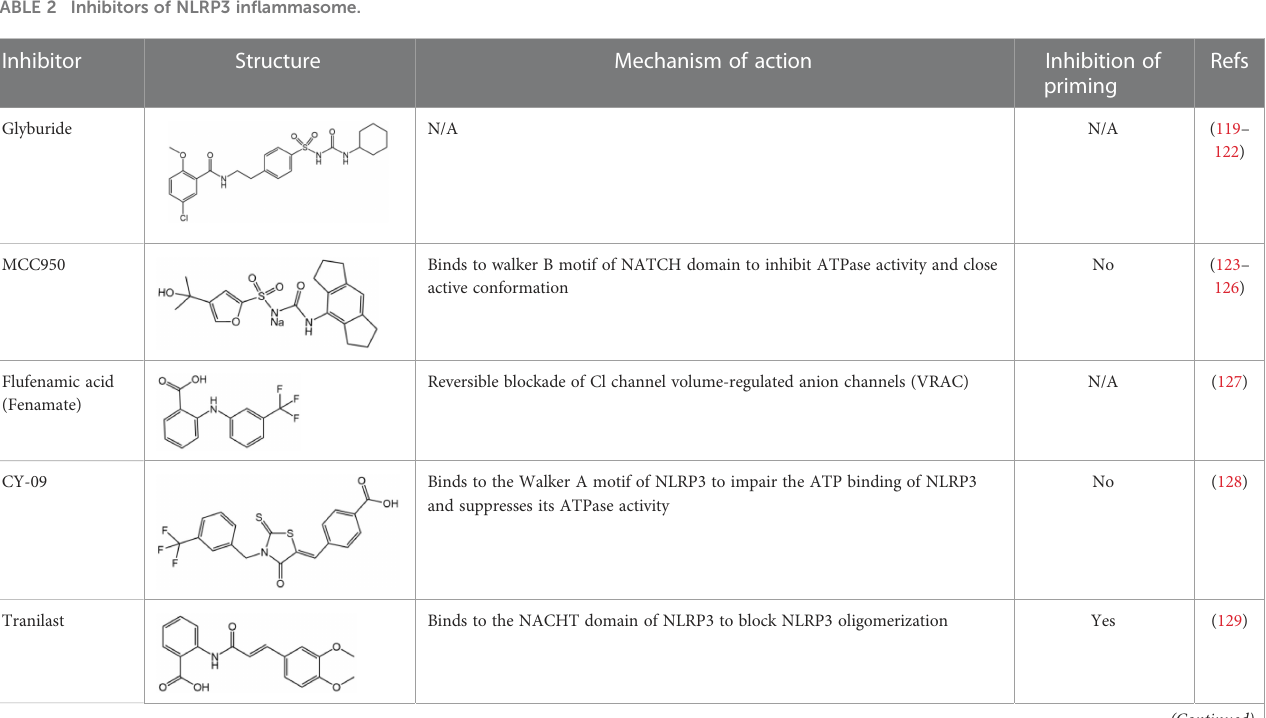
TABLE 2 Inhibitors of NLRP3 in fl